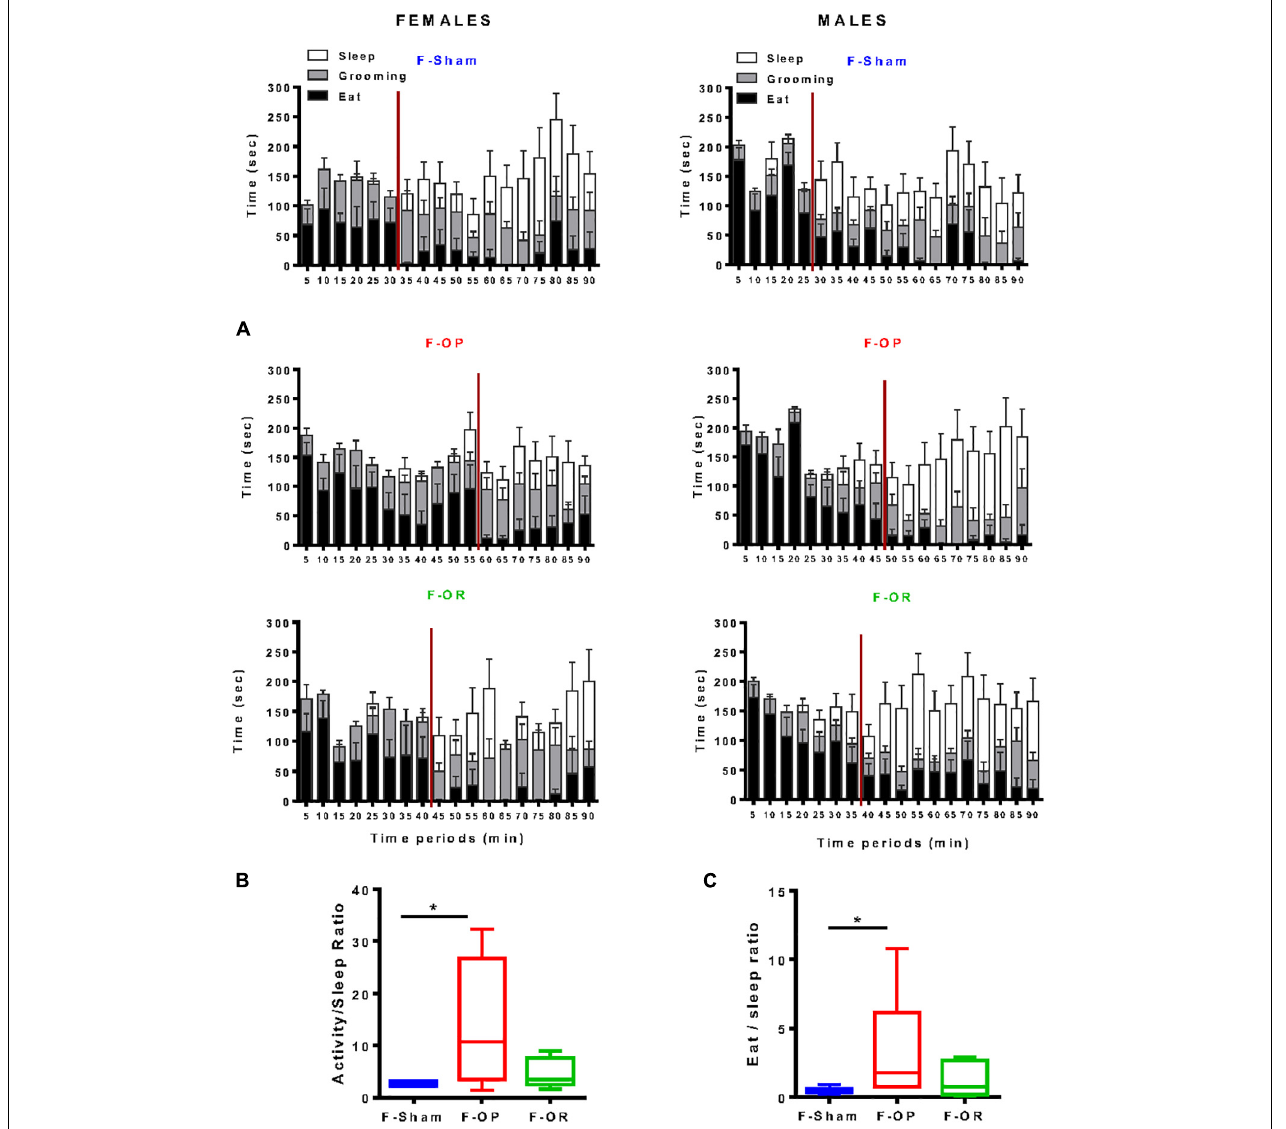
FIGURE 10 | Behavioral satiety sequence. (A) Blundell representations of behavioral satiety sequences for the three groups of females (left, n = 7–9) and males (right, n = 8–11), data are means ± SEM, satiety point is represented by the red vertical line and correspond to latency before behavioral switch between eat and sleep. (B) Activity-to-sleep ratio and (C) eat-to-sleep ratio in females ( n = 7–9); data are medians and min–max values, * p < 0.05 indicates difference between groups, Kruskal–Wallis and post hoc Dunn’s test. Animals were 130-day old and fed